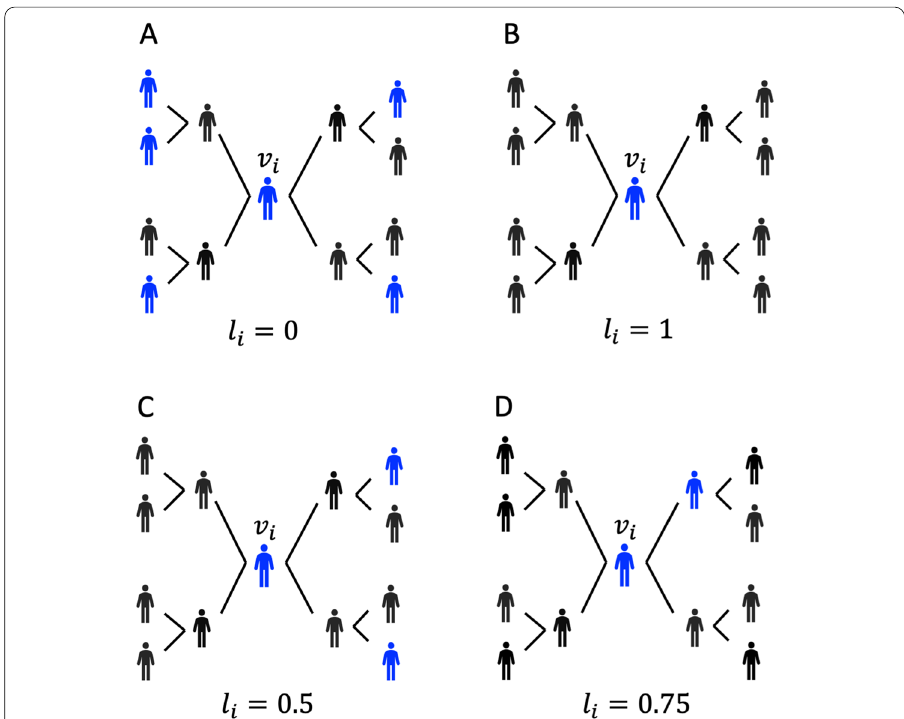
Fig. 1 Diagram of the linchpin score, showing examples of a linchpin score measure of 0 ( A ), 1 ( B ), 0.5 ( C ), and 0.75 ( D ). Blue nodes have the same value for attribute c as node